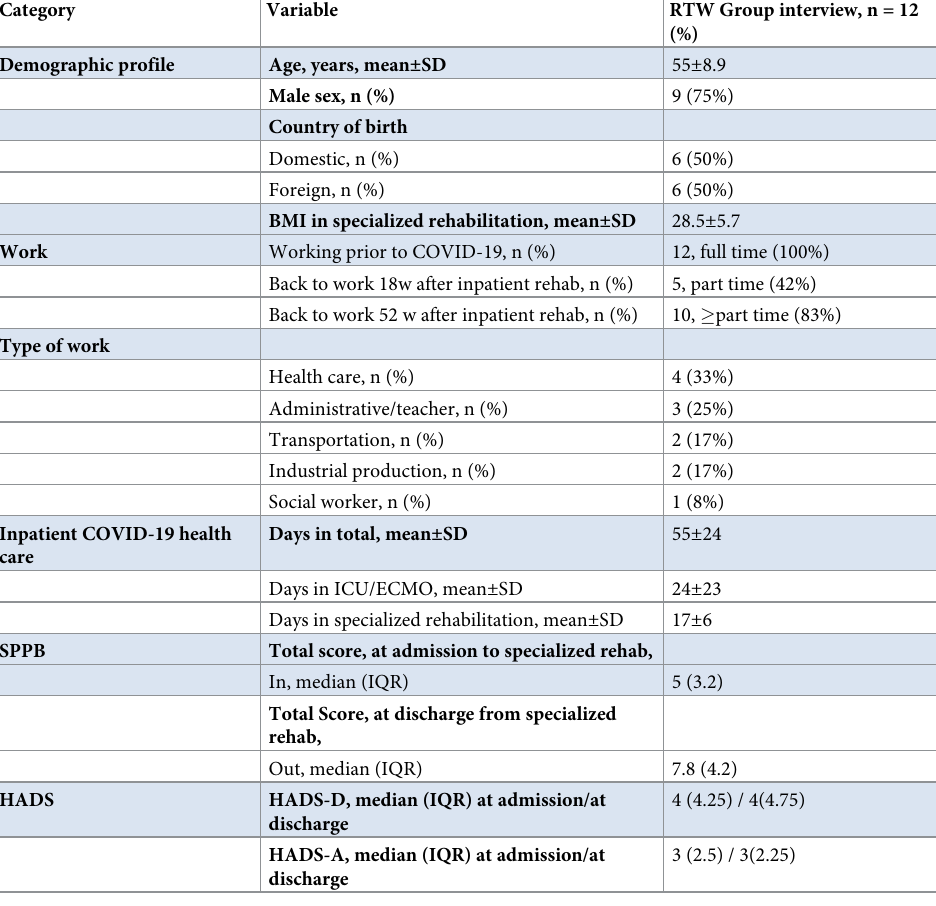
Table 1. Descriptive statistics of severe COVID-19 study sample,